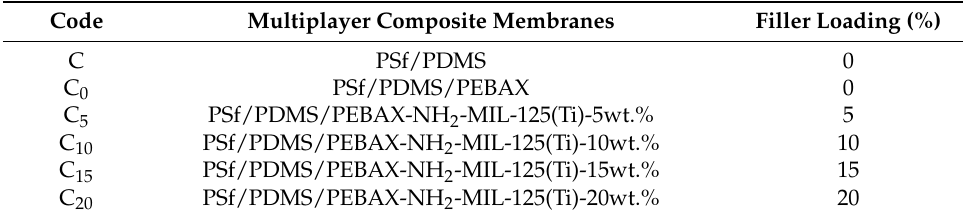
Table 1. Membranes prepared in our previous work [25] used in this study. Code Multiplayer Composite